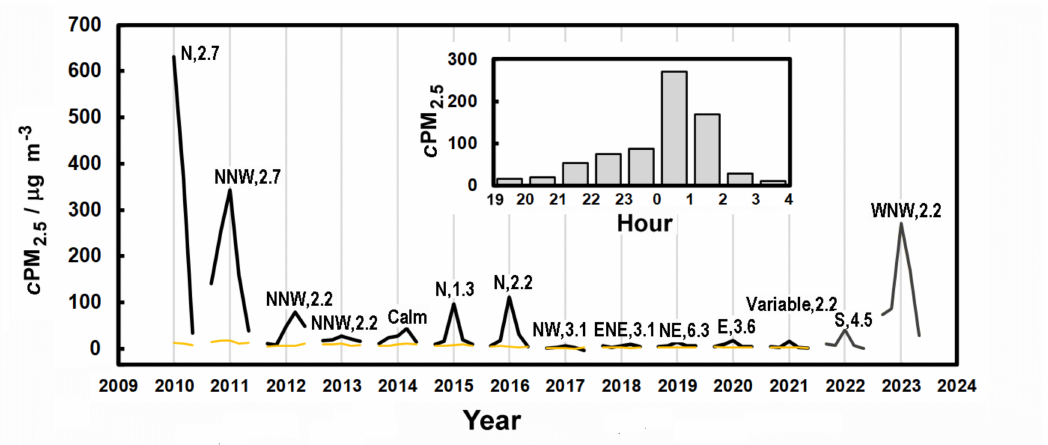
Figure 2. PM 2.5 concentrations across the time window 19:00 to 04:00 at New Year in Honolulu (dark broken line). Each peak is labelled with the wind direction and speed (m s − 1 ) from the hour after midnight. The inset shows the hourly values across a longer time window for the year 2023. The light-coloured line shows the random forest predictions of concentration based on weather and time parameters, which gives an indication of the concentrations in the absence of